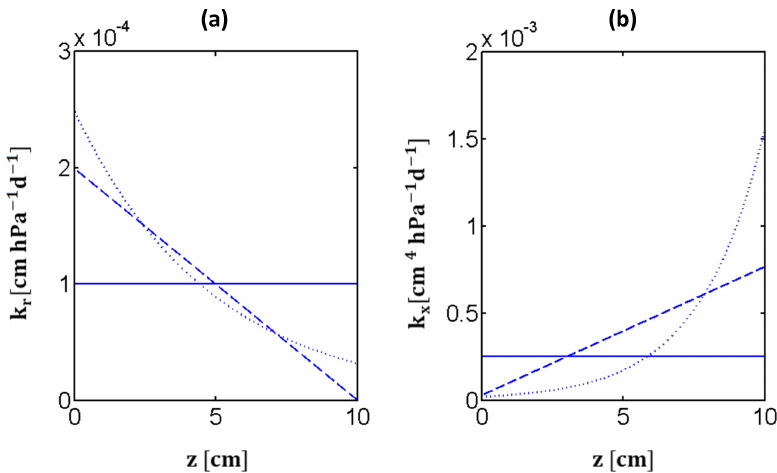
Figure 4. Variation with distance to root tip of radial conductivity (a) and axial conductance (b) along a single root with constant hydraulic properties (solid blue line), a single root with linear hydraulic profiles (dashed lines) and a single root with exponential hydraulic profiles (dotted lines). The origin of the z axis is at the root